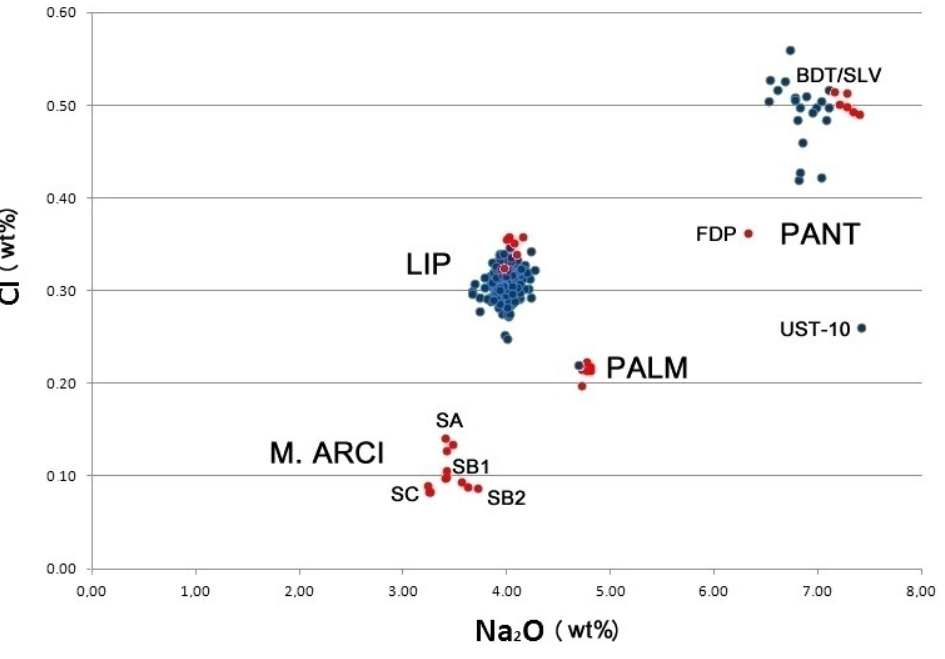
O vs Cl graph selects unambiguously the four sources of obsidian from the Central Mediterranean. In the plot are Figure 7: The binary Na 2 inserted 31 geological samples (red dots) representative of the four obsidian sources: Monte Arci, Palmarola, Lipari, and Pantelleria; and 174 archaeological samples (blue dots) attributed to Lipari (152), Pantelleria (21) and Palmarola (1) (Foresta Martin et al., 2017). Abbreviations as in Figure 3. SA, SB1, SB2, SC are M. Arci